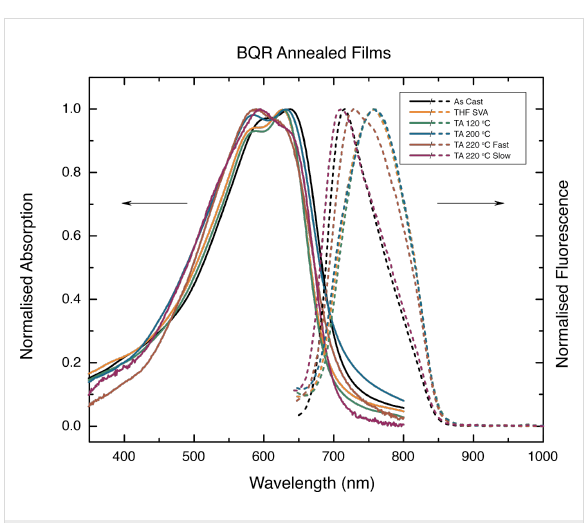
on the thin films (Figure 7c), has been examined in more detail.